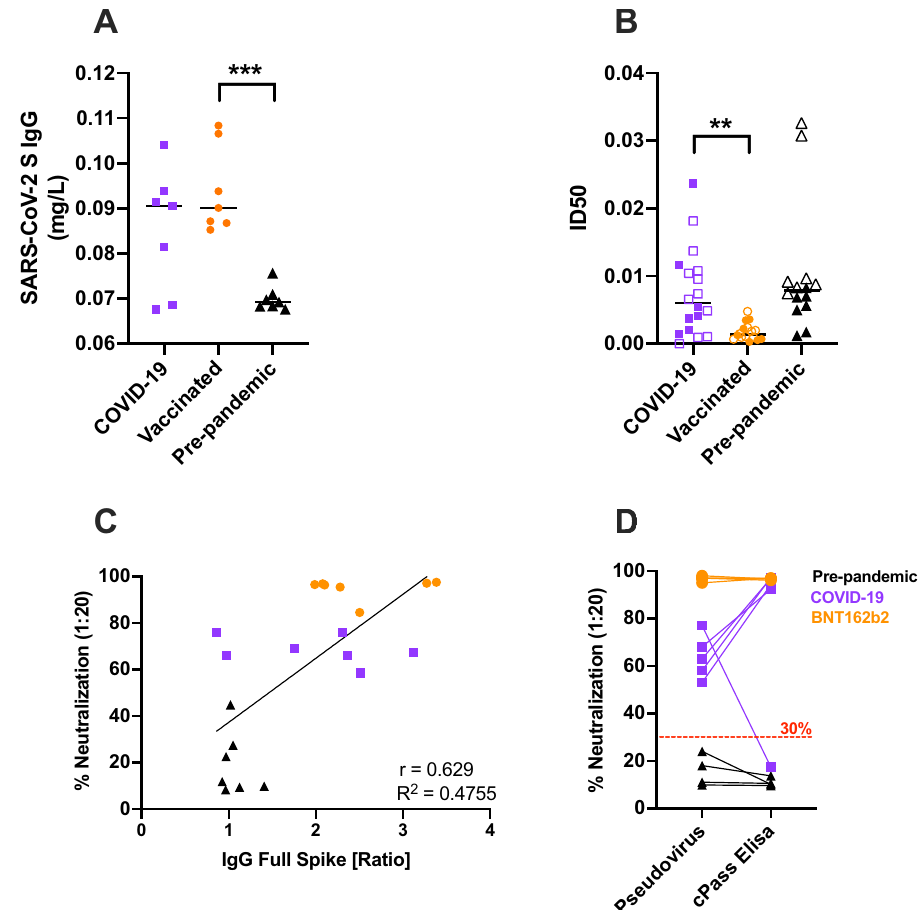
Figure 6. Anti-SARS-CoV-2 S total IgG underestimates neutralization potential evaluated using the SARS- CoV-2 pseudotyped VP-based assay. ( A ) SARS-CoV-2 S ELISA-based quantification of total IgG in COVID- 19 convalescent sera, BNT162b2 vaccinated sera and pre-pandemic sera. ( B ) ID50 of all samples tested with SARS-CoV-2 S pseudoVP assay. Fully colored symbols indicate matched samples also tested in ( A , C , D ). ( C ) Correlation 1:20 sera neutralization potential vs. SARS-CoV-2 S IgG ratio. Purple: COVID-19 convalescent sera, orange: vaccinated sera, p < 0.001 (***) Black: pre-pandemic sera. ( D ) Comparison of COVID-19, BNT162b2 and pre-pandemic sera neutralization with pseudotyped VP-based assay and cPass SARS-CoV-2